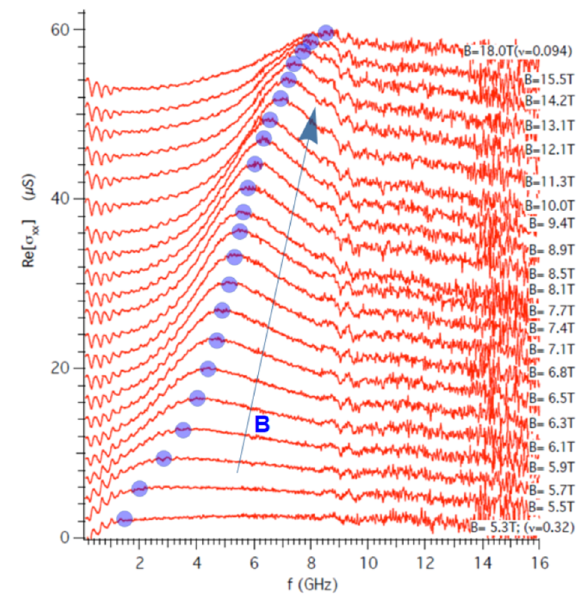
Figure 3 . Experimental data for a 15nm wide AlGaAs/GaAs/AlGaAs quantum well (QW) taken from [39]. The behavior as a function of the magnetic (cid:12)eld is highlighted. Measured data, and in particular the scaling ! pk ( B ) indicate that the disorder that dominates the pinning in this material is most likely some dilute disorder. We will come back to this point in the conclusions, section 7. The data and the (cid:12)gure are taken and adapted with permission from